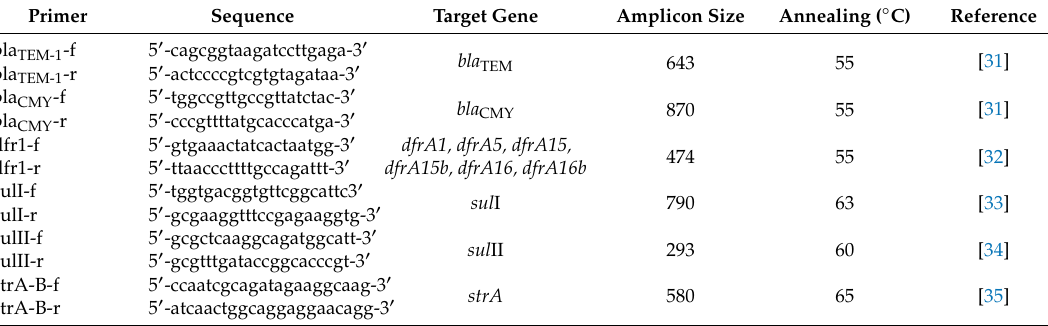
Table 3. Primers and conditions for PCR of tested resistance